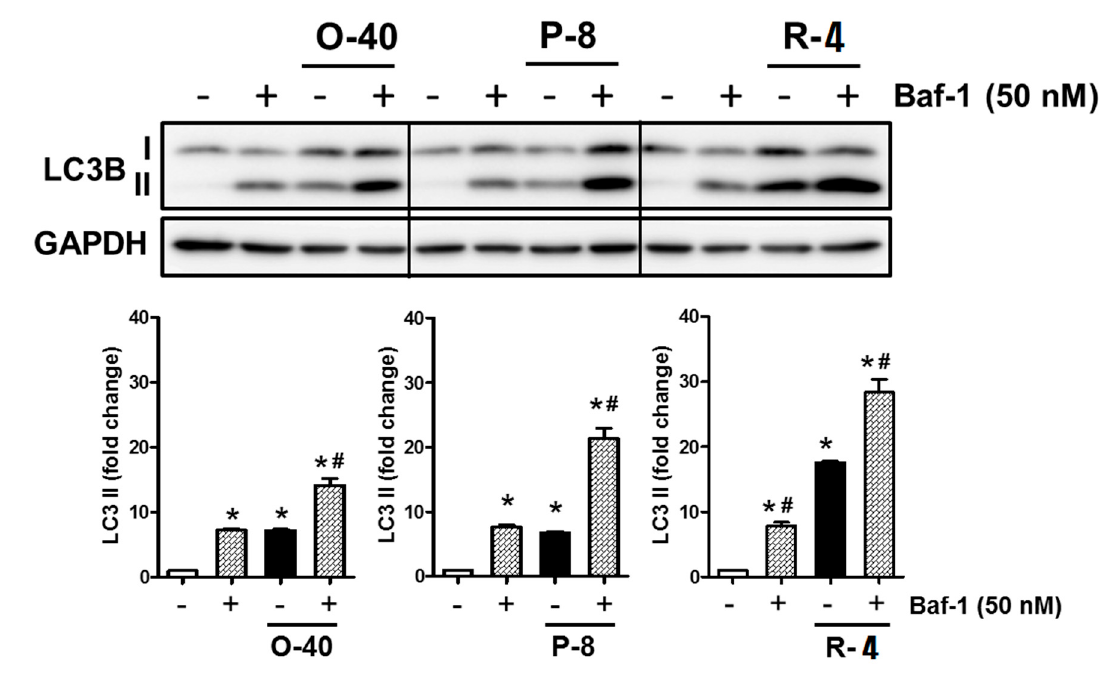
Figure 4. 5-HT3 receptor antagonists function as novel autophagy inducers in lung cancer cells. A549 cells were treated with or without ondansetron (40 µ g / mL), palonosetron (8 µ g / mL), or ramosetron (4 µ g / mL) for 24 h and then added to 50 nM bafilomycin A1 (Baf-1) 2 h before observation. The level of LC3B was determined by Western blotting. GAPDH served as a loading control; * p < 0.05 vs. untreated cells, # p < 0.05 vs. 5-HT3RA-treated cells.